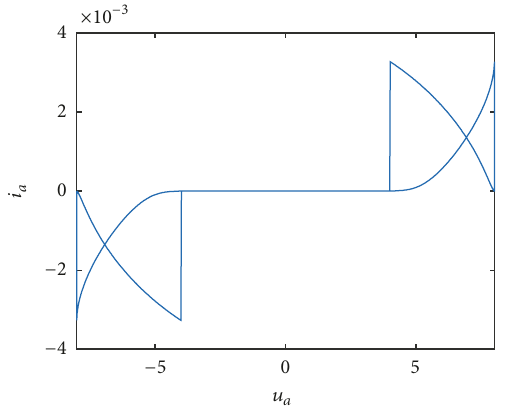
Figure 4: Locus in 𝑢 a − 𝑖 a plane.